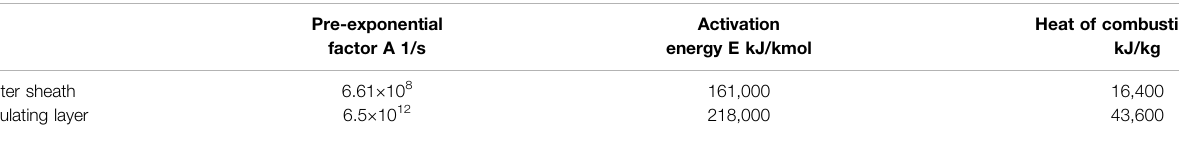
TABLE 2 | Pyrolytic combustion parameters of cable